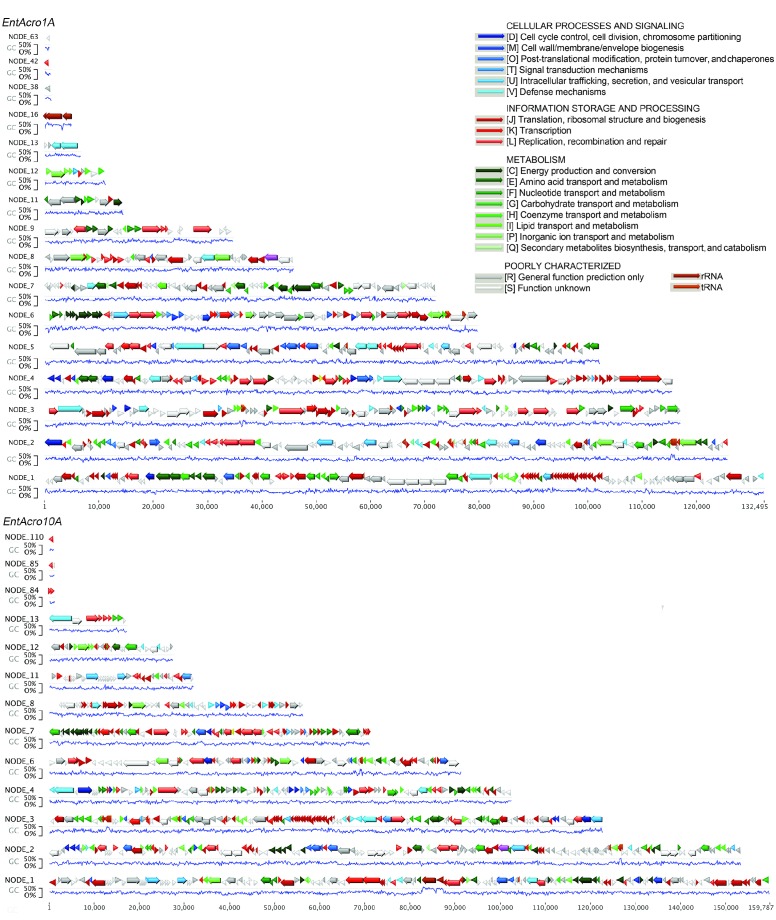
Overview of the assembled draft genome contigs of EntAcro1A (top) and EntAcro10A (bottom).Functional annotation was performed using the eggNOG database (see Materials and methods). The functional categories and subcategories for the predicted coding sequences (CDS; arrows) are given in colors following the top right legend. Gene orientation is shown by the direction of arrow heads and the GC content of sequences is given just below the predicted CDS. Numbers under the GC content show length in basepairs (bp) and contig identifiers are given at the top left of each contig, using the same headers as the ones deposited in the NCBI database. Analyses revealed 338 and 358 poorly or uncharacterized proteins for EntAcro1A and EntAcro10A, respectively, which is ca. 25% and 21% of their draft genomes similar to percentages in 14 other closely related insect-associated Mollicutes that have 18 – 25% of their genomes encode predicted genes of unknown function (source data file 4). Of the remaining CDSs in EntAcro1A, 153 were associated with metabolism (green), 196 with information storage and processing (red), and 72 with cellular processes (blue). Figures for EntAcro10A were similar for information storage and processing (196) and cellular processes (71) genes, but there were fewer (133) CDSs associated with metabolism.